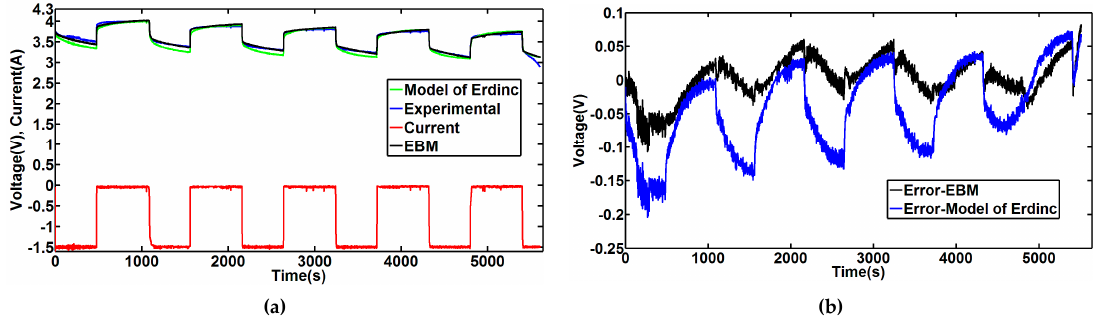
Figure 11. Simulation and experimental curves for 1.5 A current ( a ) voltages and current, ( b ) voltages error.